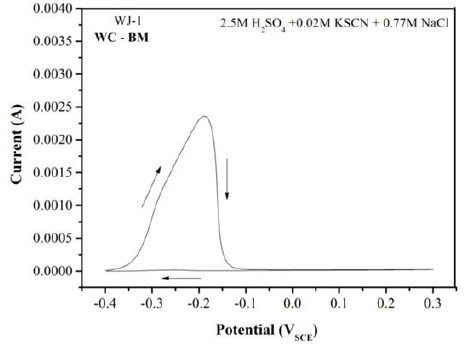
Figure 10. BM of the WJ1-WC with solution containing 0.77M NaCl.